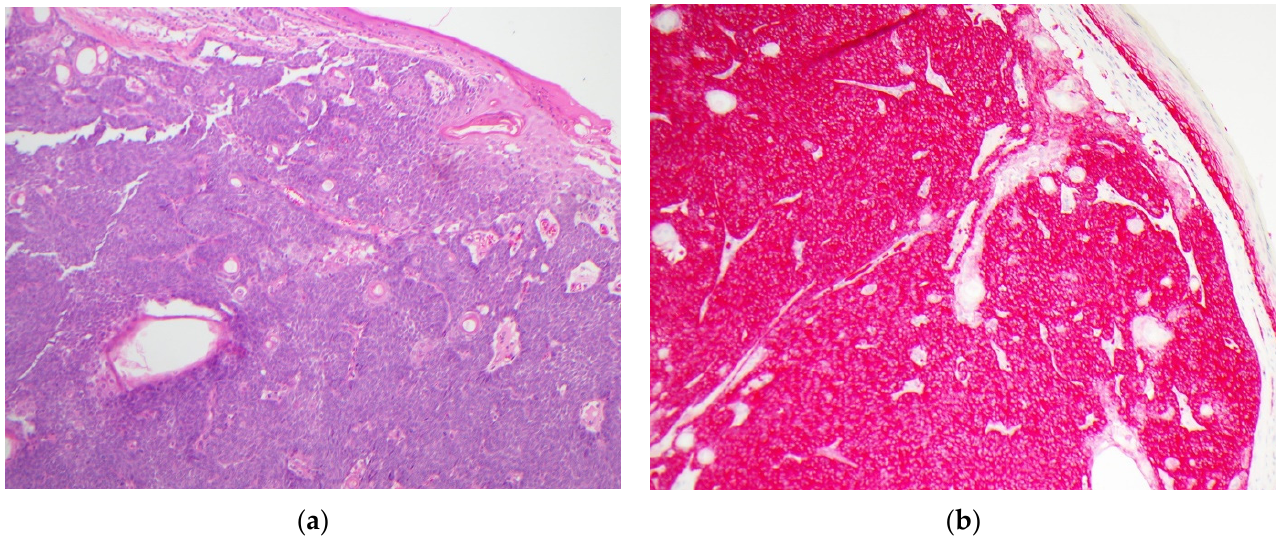
Figure 1. Sebaceous carcinoma, sample case. ( a ) Hematoxylin and eosin-stained section showing an infiltrative proliferation